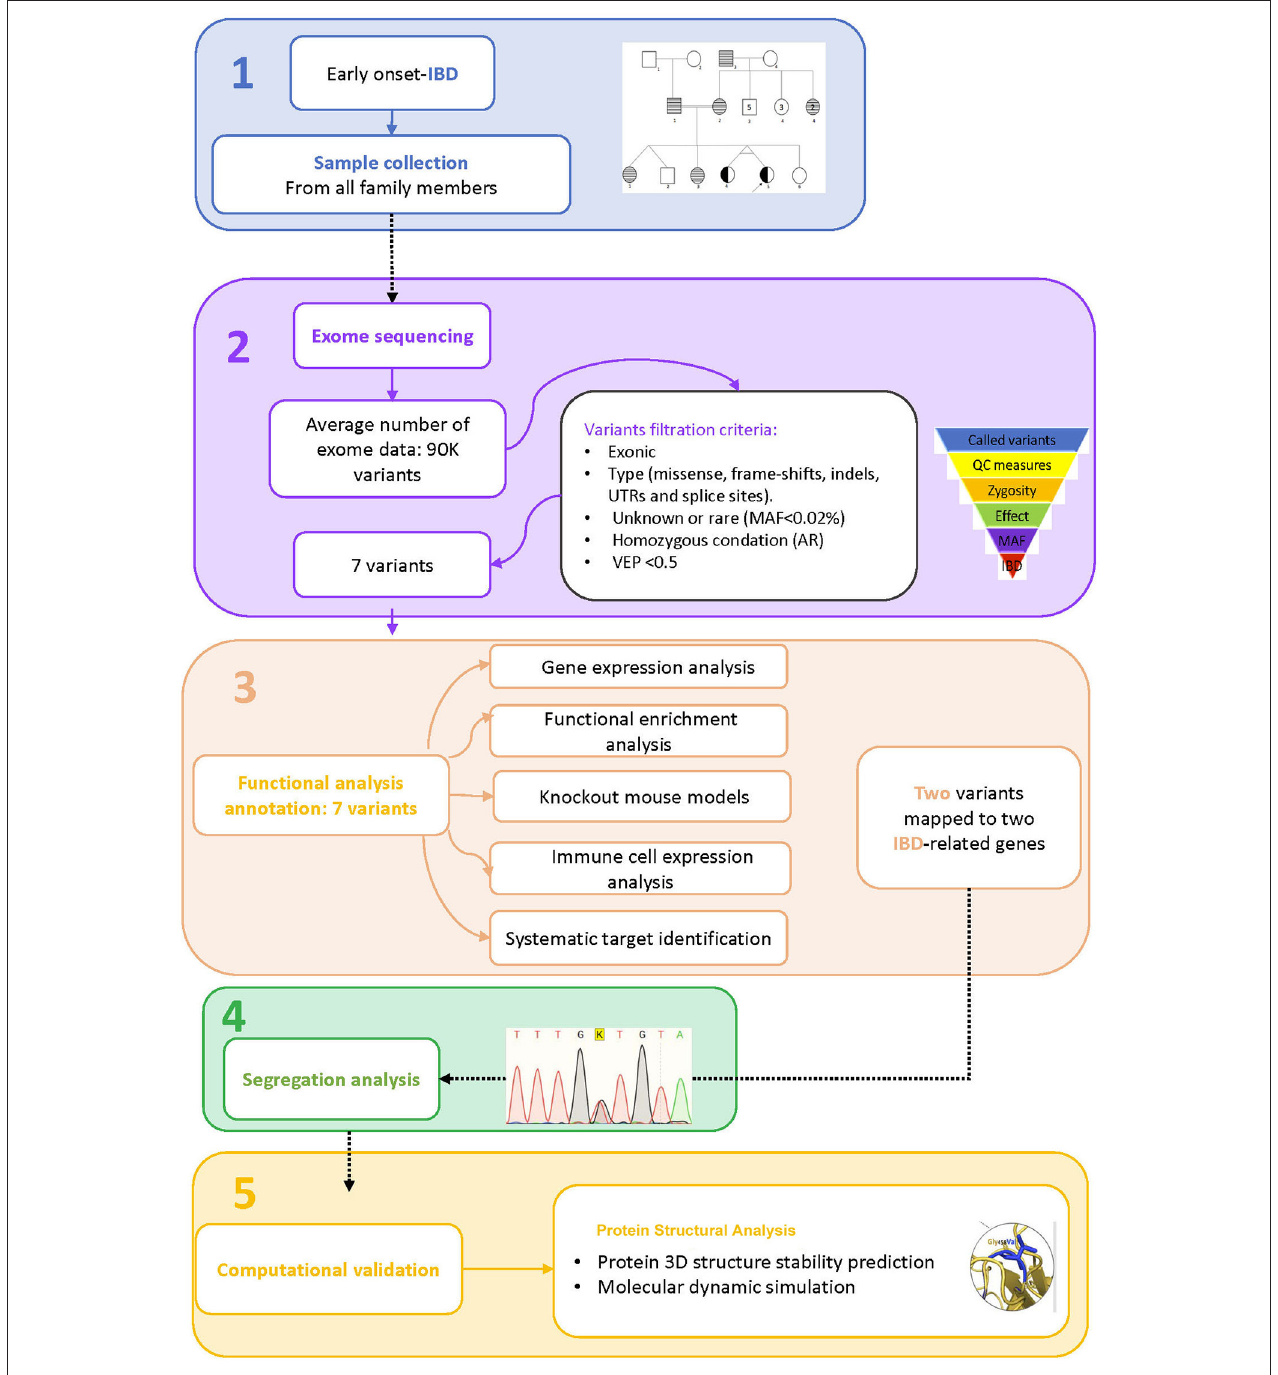
FIGURE 1 | Study workflow. 1. Sample collection, 2. Exome sequence analysis, 3. Functional analysis annotation, 4. Segregation analysis, 5. Computational